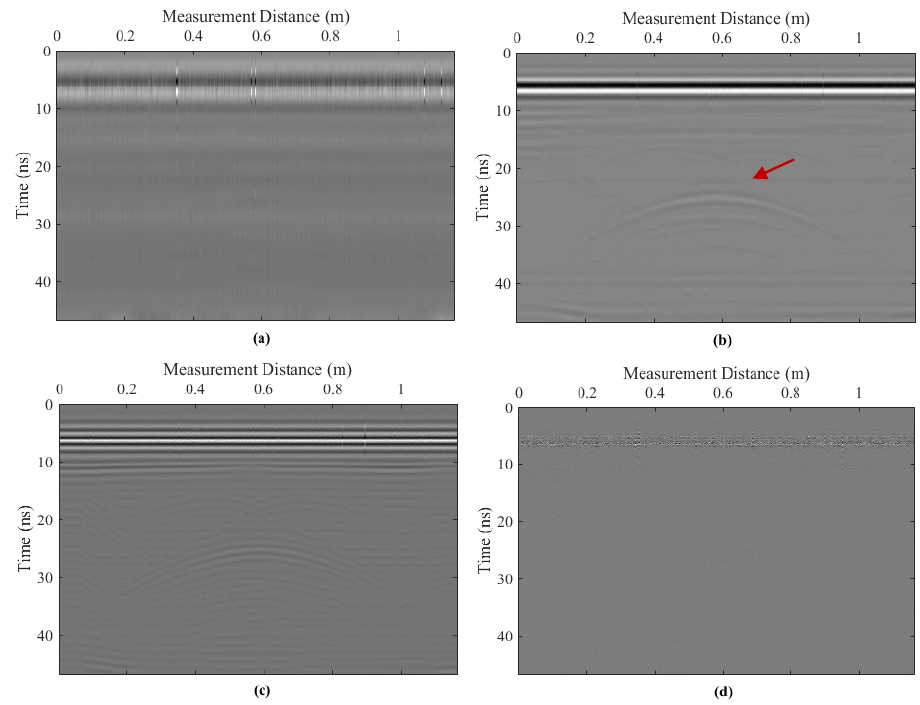
Figure 9. The derived IMF-slices using VMD. ( a – d ) show the IMF-slice 1–4 respectively.